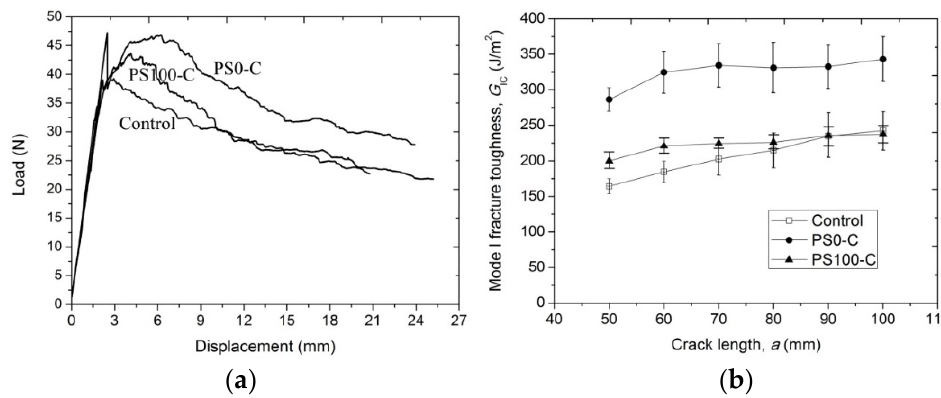
Figure 6. Typical load–displacement curves of the ENF test.